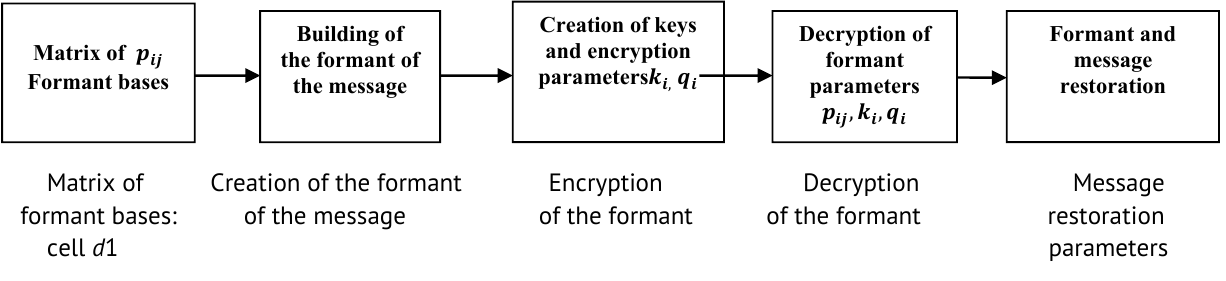
Figure 1 . AB1 algorithm